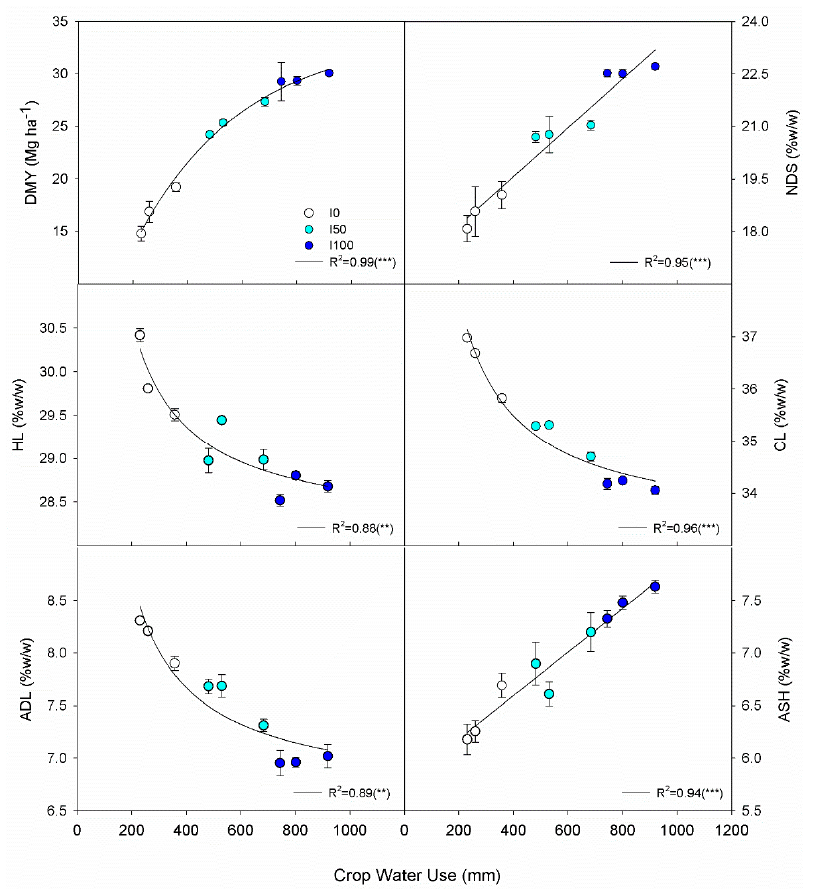
Figure 3. Relationships between crop water use (mm) and dry matter yield (DMY), and biomass composition (neutral detergent soluble — NDS, hemicellulose — HL, cellulose — CL, acid detergent lignin — ADL, and ash content) of Saccharum under changing irrigation and growing season. Regression significance indicated by ** at p ≤ 0.01 , ** * at p ≤ 0.001.